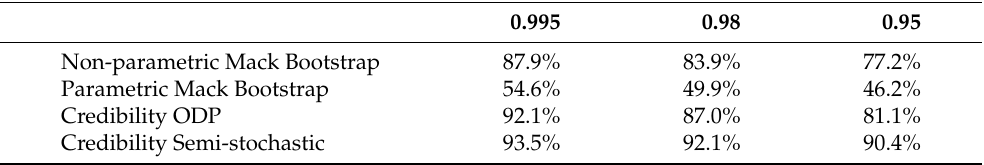
Table 5. The ratio of one-year 99.5%-, 98%- and 95%-VaRs exceeding the multiyear actuals. Results are based on the combined 355 observation from 6 business lines.